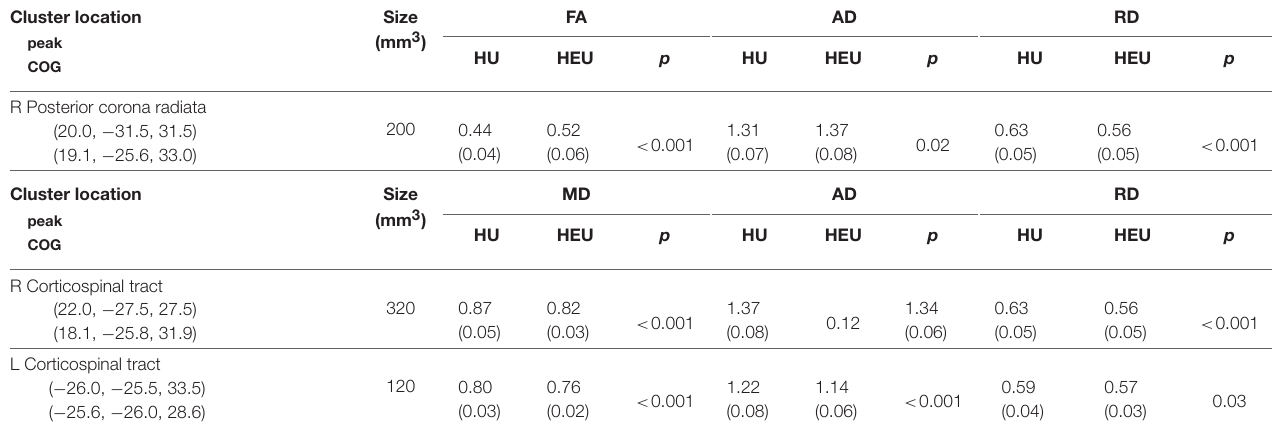
TABLE 3 | Peak (top) and center of gravity (COG) (bottom) MNI coordinates of clusters showing significant differences in FA or MD between HU and HEU children. Cluster location Size FA AD RD peak (mm 3 ) HU HEU p HU HEU p HU HEU p COG